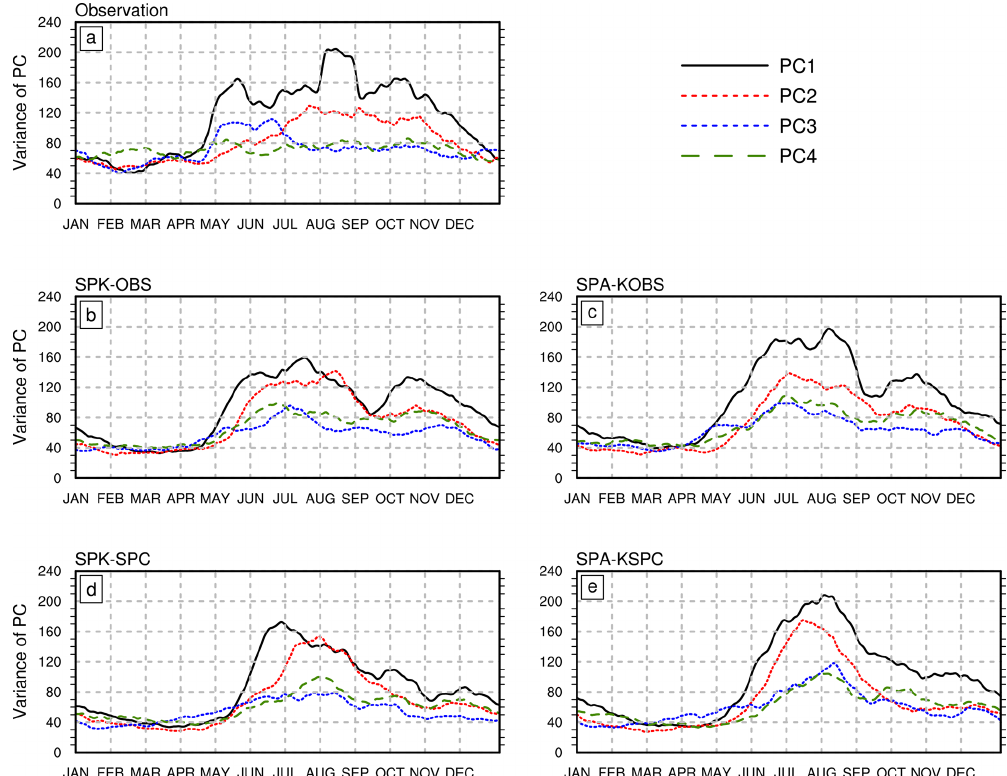
Figure 9. Seasonal cycle of variance of the four leading PCs for (a) NOAA OLR and ERAI u 850 , (b) SPK-OBS, (c) SPA-KOBS, (d) SPK- SPC, and (e) SPA-KSPC. A 30d running mean is applied to the seasonal cycle of each